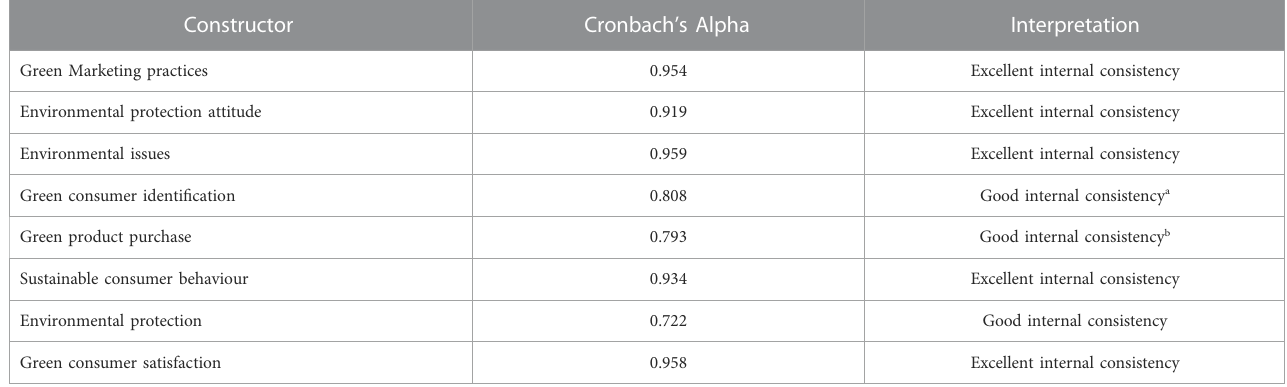
TABLE 3 Results of Cronbach ’ s Alpha